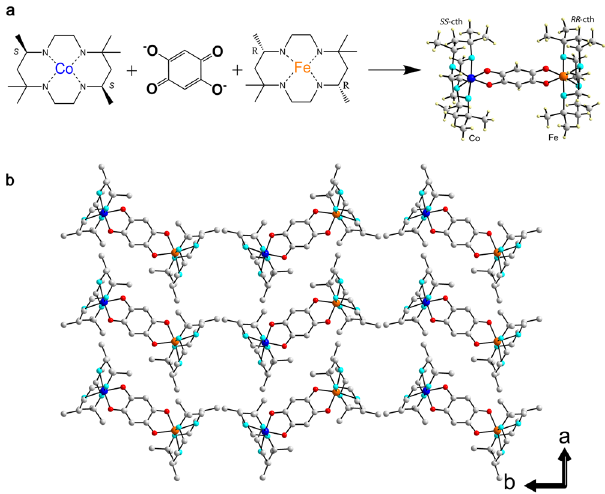
Fig. 1 Synthetic strategy and crystal structure of the [FeCo]